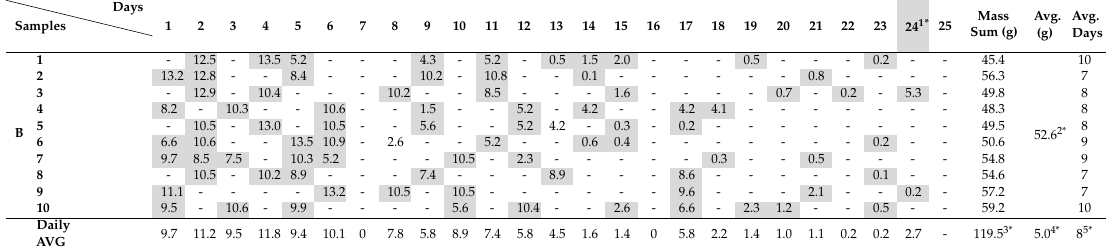
Table 6. Oil leakage mass measurement result (specimen